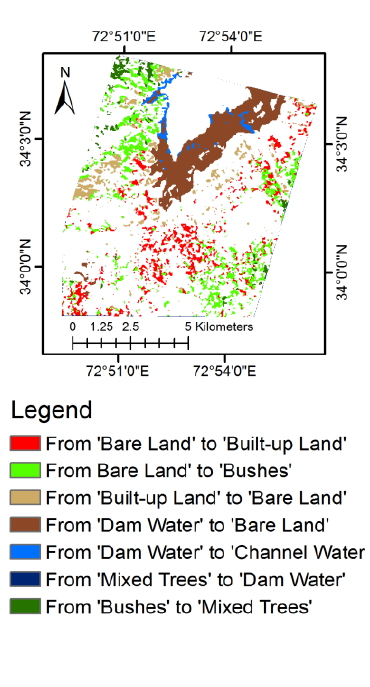
Figure 3. Change detection results of OLI SVM classified data from winter to summer 3.5 Change Detection from Winter to Autumn (case 3)